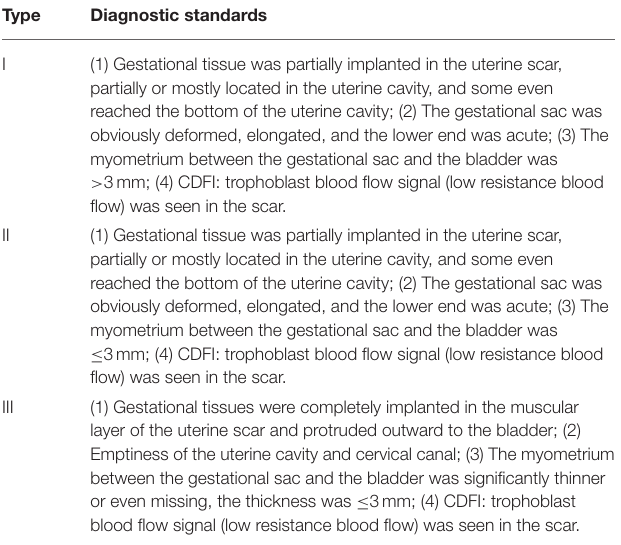
TABLE 2 | CSP classification according to the Family Planning Group, the Chinese Medical Society of Obstetrics, and Gynecology Expert Consensus on Diagnosis and Treatment of Cesarean Section Scar